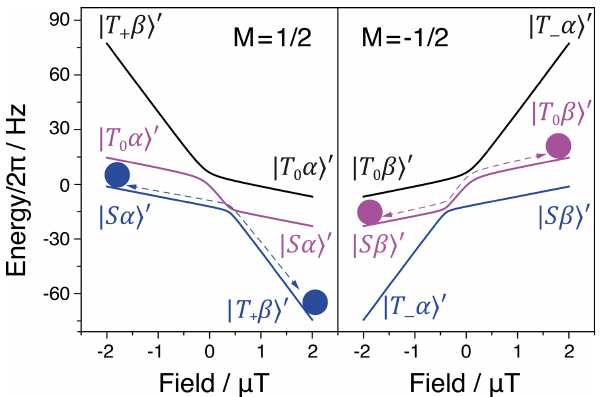
Figure 5. The two state manifolds of a three-spin I 1 I 2 S system with F z = ± 1 / 2. The balls represent the state populations in the initial and final state, while the arrows show the adiabatic pathways. J HH = 15 . 7Hz, J 1 S = 6 . 6Hz, J 2 S = 3 .